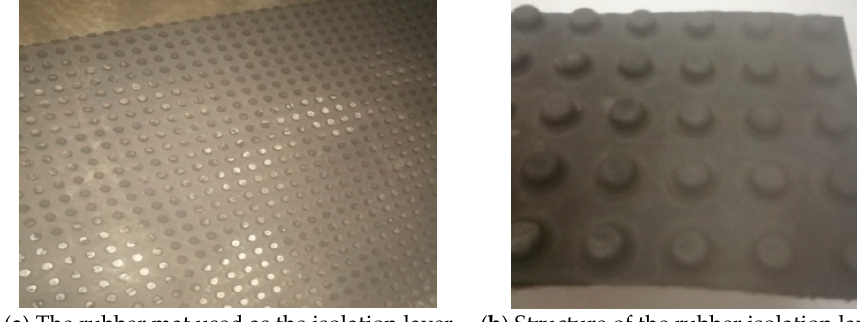
Figure 3. Rubber isolation layer: ( a ) rubber mat, ( b ) structure.